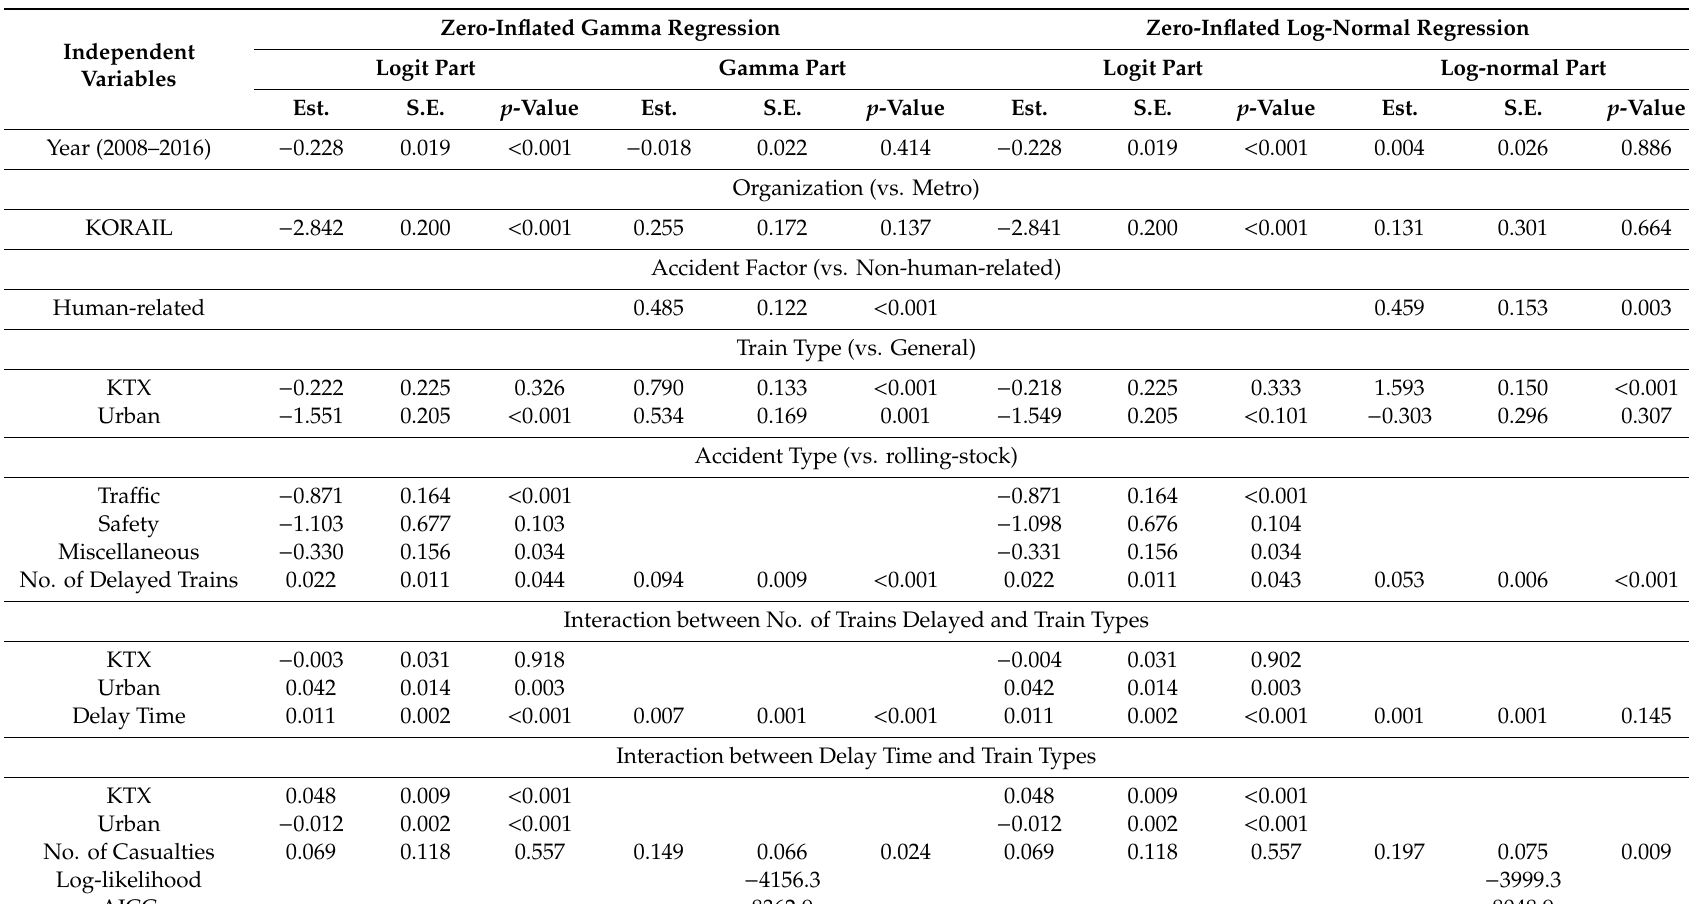
Table 6. Two-Part Regression Analyses of Amount of Costs due to Railway